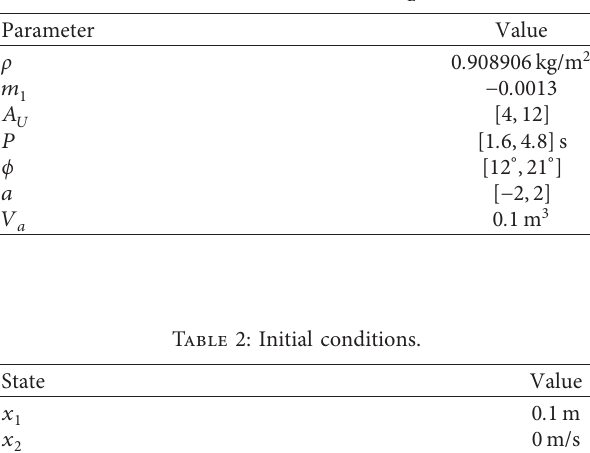
Table 1: Parameters of A